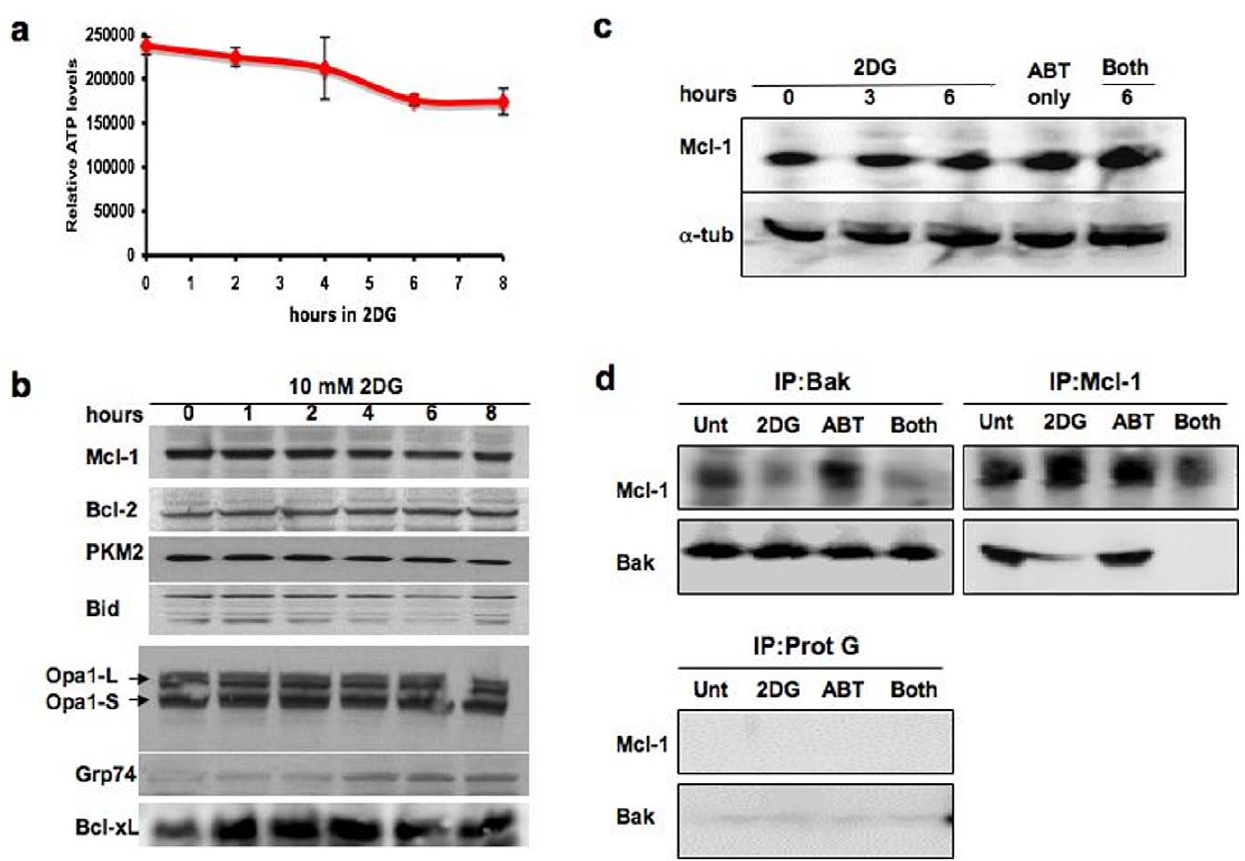
Figure 5. 2DG disrupts Bak-Mcl-1 association, priming cancer cells without lowering protein levels of Mcl-1. a, The effect of 2DG on cellular ATP levels. The amounts of ATP were measured during HeLa cell culture with 10 mM 2DG in the presence of 25 mM glucose in DMEM supplemented with 10% serum. b, Protein profiles during 2DG incubation of HeLa cells. Samples were taken from HeLa cells treated as in a , and various protein contents of pro- and anti-apoptotic proteins were analyzed by Western blots. In this experiment, we see increases in Bcl-xL for the first hour. When we repeated the experiment twice, Bcl-xL levels remained the same. c, Mcl-1 levels remained unchanged during 2DG-ABT- induced apoptosis. PPC-1 cells were treated with 10 mM 2DG for 6 hours, 1 m M ABT-263 for 3 hours, or 10 mM 2DG for 6 hours of which the last 3 hours were incubated with 1 m M ABT-263. d, Bak and Mcl-1 do not co-precipitate in 2DG treated cells. PPC-1 cells were treated as in c . Bak and Mcl-1 were immunoprecipitated by specific antibodies conjugated to Protein G-Sepharose and the co-precipitated proteins were analyzed by Western blots. Left Upper Panels , Bak co-precipitates, Right Upper Panels , Mcl-1 co-precipitates, and Left Lower Panels , Protein G-Sepharose precipitates. For technical reasons, we could not immunoprecipitate Bcl-xL and analyze its